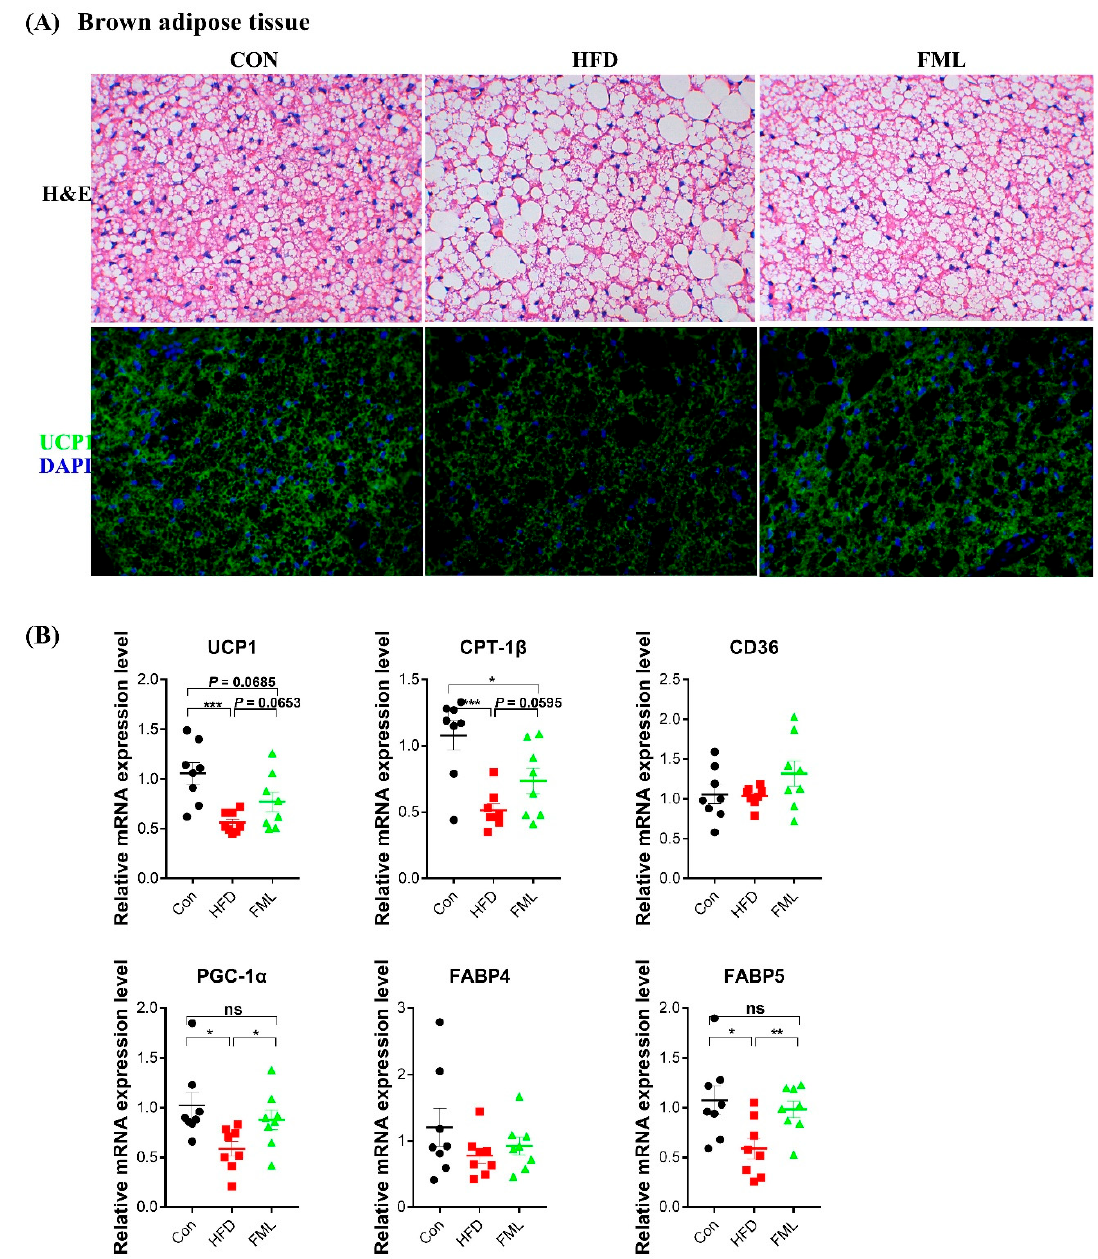
Figure 4. FML administration stimulated BAT browning and thermogenesis in HFD-fed mice. ( A ) H&E and UCP1 immunofluorescence staining of representative BAT sections ( × 400), ( B ) relative mRNA expression of markers for thermogenesis (UCP1), mitochondrial biogenesis (PGC-1 α ), fatty acid catabolism (CPT-1 β ), and lipid uptake (CD36 and FABP) in BAT ( n = 8). Data are presented as mean ± SEM, di ff erences were denoted as follows: * p < 0.05, ** p < 0.01, *** p < 0.001; ns p > 0.05.